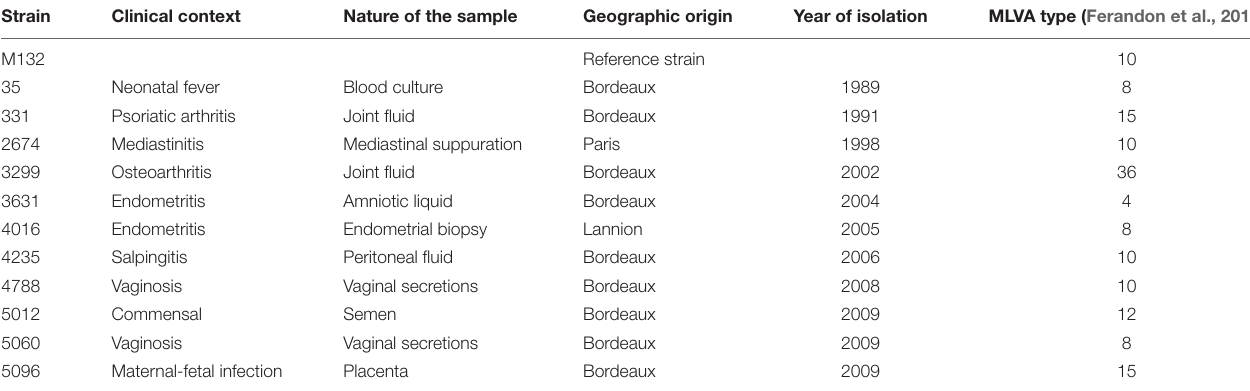
TABLE 1 | M. hominis strains used for genome